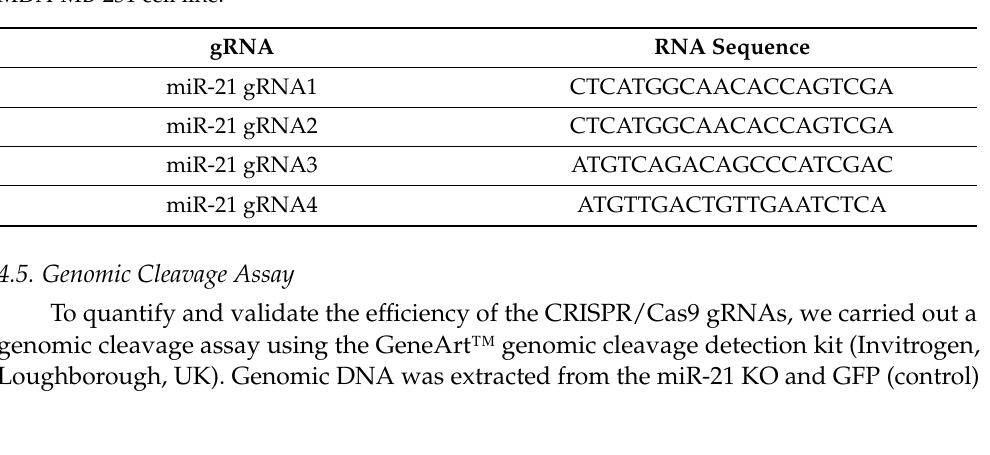
Table 1. Sequences of the four guide RNAs (gRNAs) used to knock out the miR-21 gene in the MDA-MB-231 cell